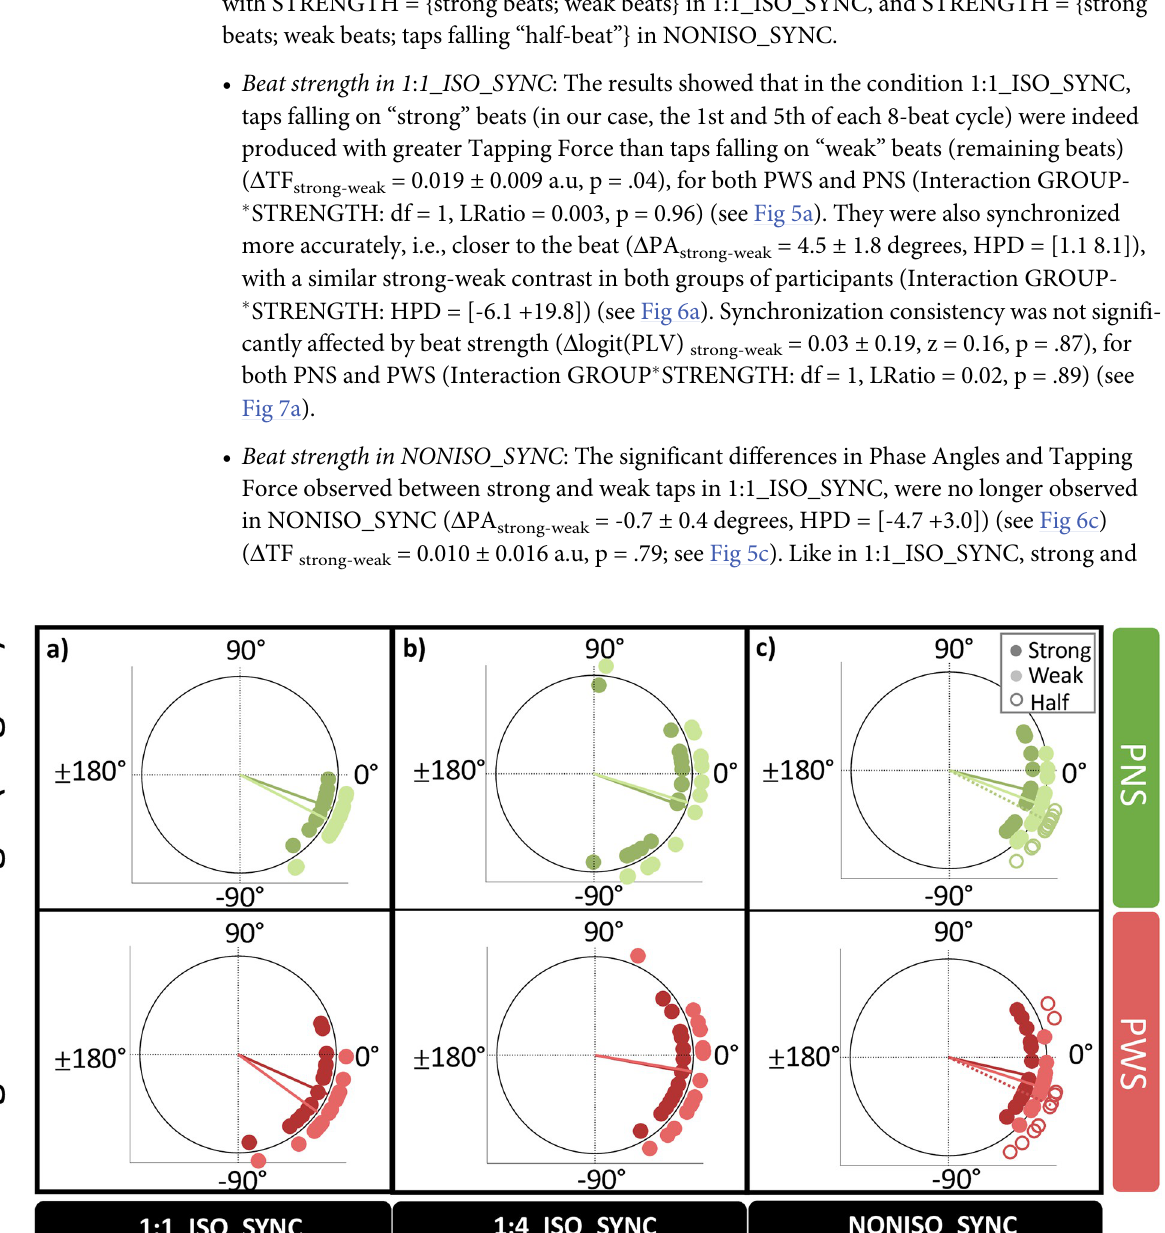
PLOS ONE | https://doi.org/10.1371/journal.pone.0276691 February 3,